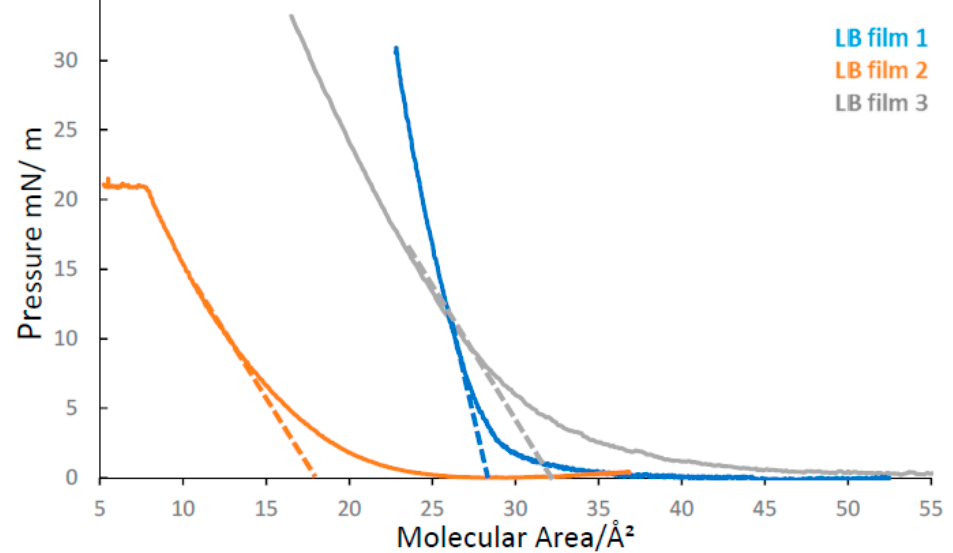
Figure 2. Isotherms for 1 , 2 and 3 . Molecular head areas shown in Table 1. The dashed line indicates a fit of the solid phase data to obtain the molecular head area. See text for detail. Molecular head areas were determined by a fitting procedure using linear regression on a subset of the data, from what was determined to be the solid phase (just before the collapse of the film). Extrapolating the fitted line to the “Molecular Area” axis (see Figure 2) provides the molecular head area for each DADQ.